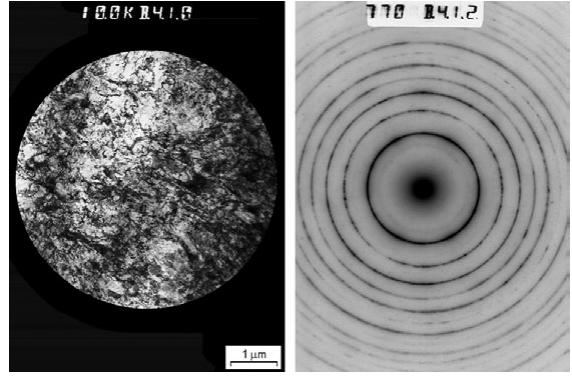
Table 1. Microhardness values HVm 50 measured in the surface layer of the influenced rail-chip, before and after annealing 300°C / 4 hrs Surface layer with the Fig. 3. TEM-image of the region where the selected electron ‘nanostructure’ component diffraction was carried out; the obtained annular diffraction pattern proved that the microstructure consists of very small Measurement ferrite grains with random average 1